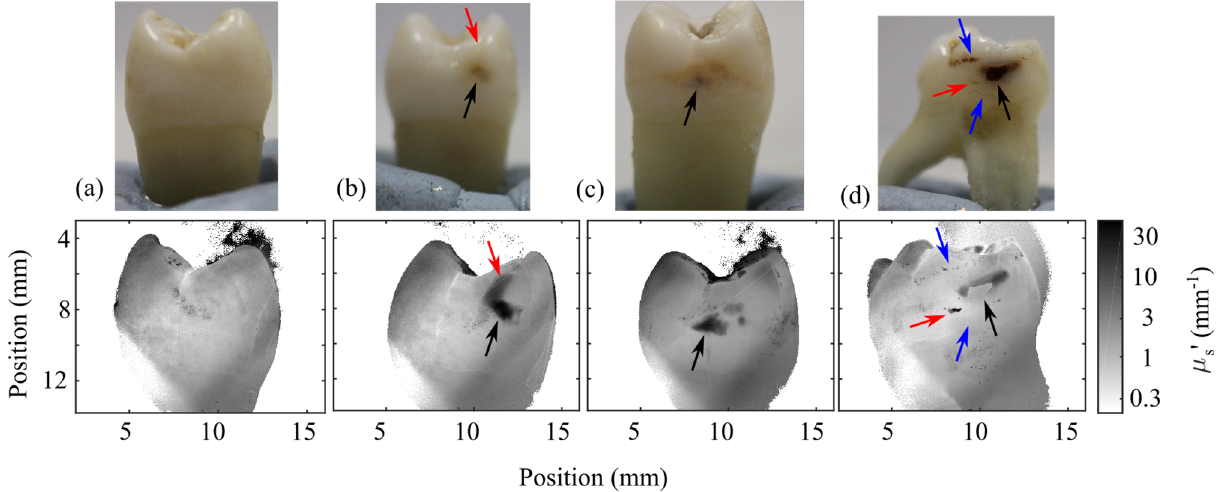
Figure 3. Visible images (top) and reduced scattering coefficients (bottom) for four teeth labelled ( a – d ). Black arrows point to cavities identified both with visible imaging and through reduced scattering coefficient, red arrows highlight cavities or demineralization identified only through reduced scattering coefficient, and blue arrows highlight surface defects that are observed in visible images but that do not significantly affect reduced scattering coefficient.